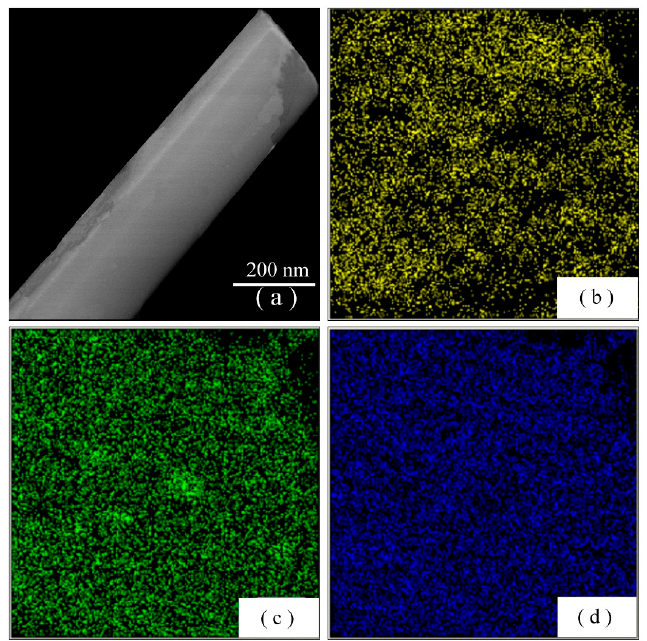
Figure 5. EDX elemental maps of O, Zn, and W along one ZnWO 4 nanoplate: ( a ) ZnWO 4 nanoplate; ( b ) O map; ( c ) Zn map; and ( d ) W map.